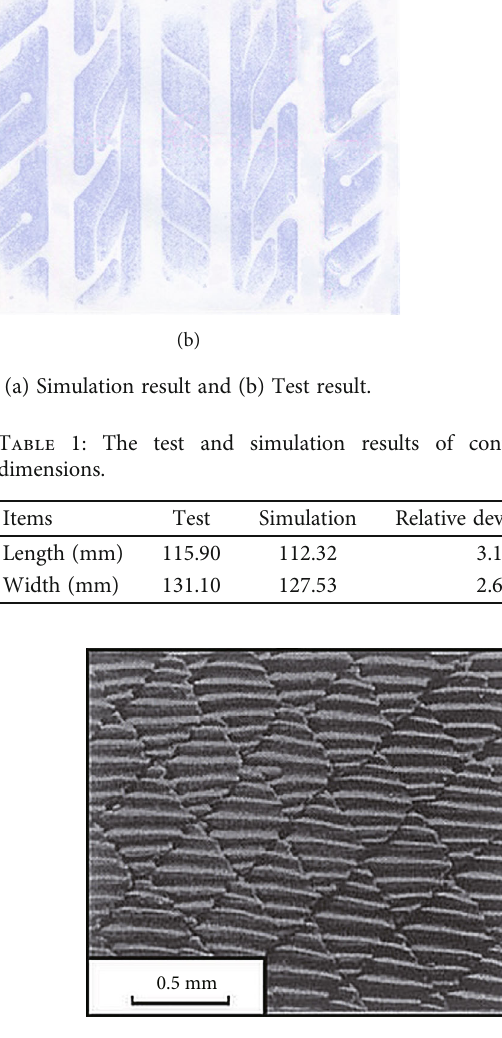
Figure 7: Scale patterns of the Galapagos shark